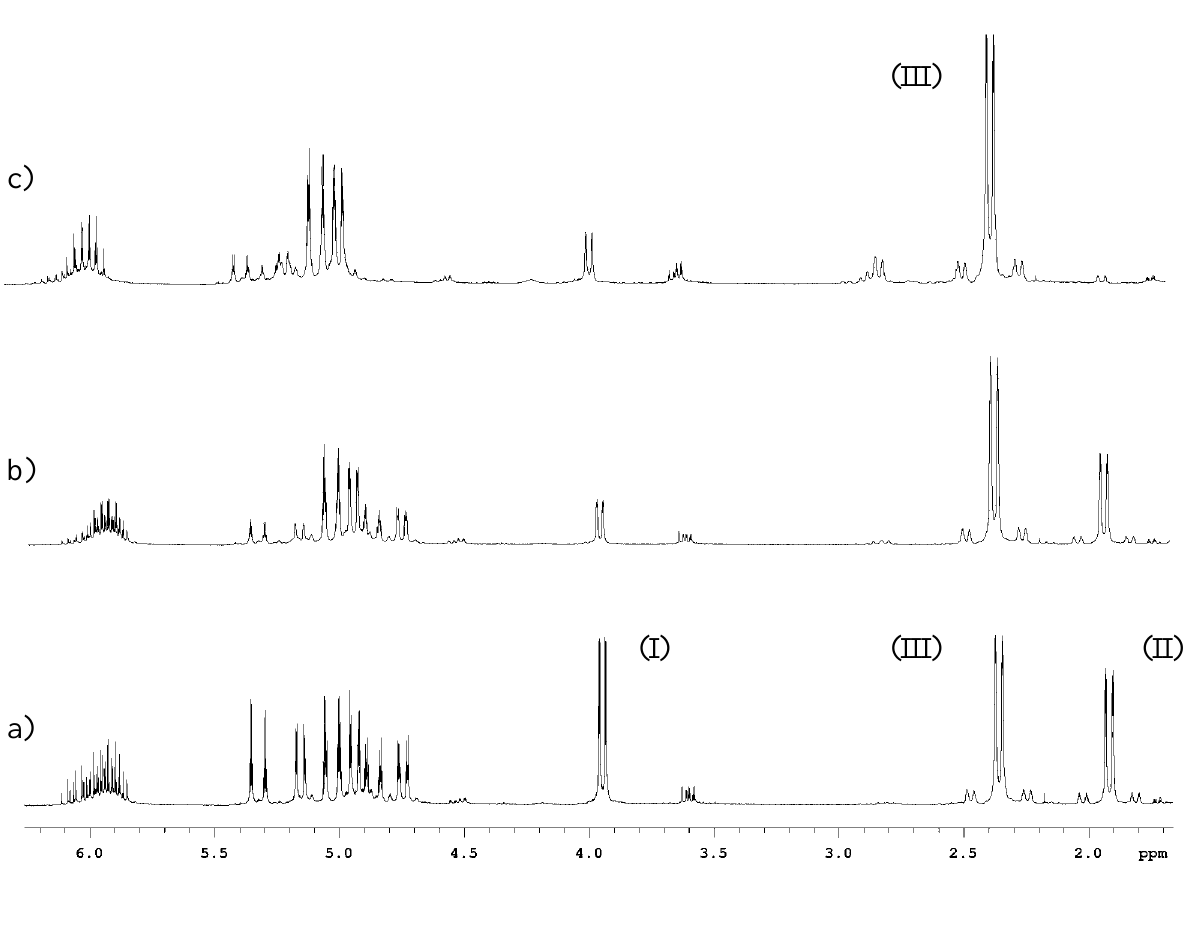
of the reaction of allyl bromide and metallic 3